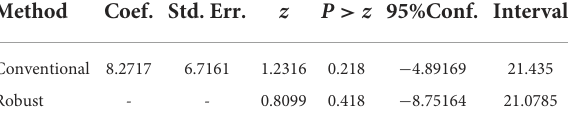
TABLE 11 Placebo test (URBAN as outcome